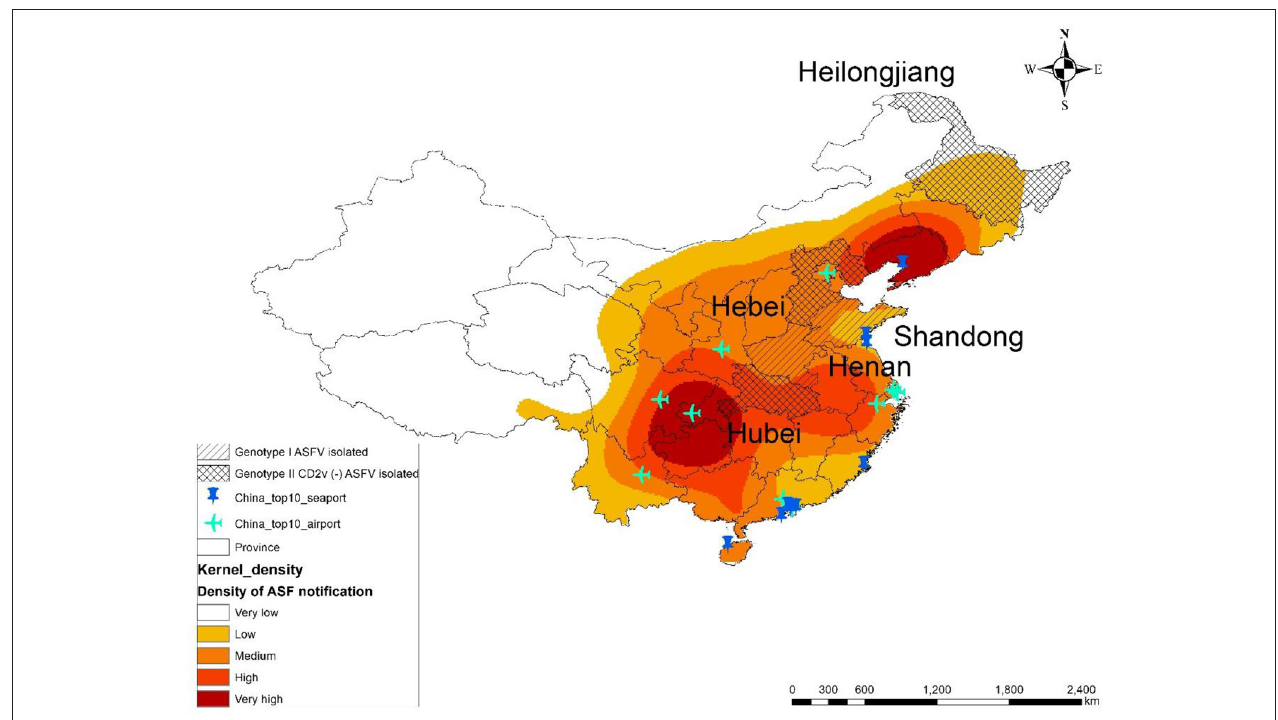
FIGURE 3 | Density of ASF notifications in China overlapped with the lower virulent ASFV reported area and China’s 10 largest airports and seaports. The graduated color shades illustrate the estimated kernel density of ASF notifications (notifications/km 2 ). Each colored area indicates frequency of ASF notification number per > 4.61 × 10 − 5 (very high), 3.11 × 10 − 5 to 4.6 × 10 − 5 (high), 1.81 × 10 − 5 to 3.1 × 10 − 5 (medium), 6.9 × 10 − 6 to 1.8 × 10 − 5 (low), and < 6.9 × 10 − 6 (very low). Provinces where ASFV genotype I and CD2v (–) ASFV genotype II were isolated are represented by a diagonal line and a grid line, respectively. The locations of China’s 10 largest airports and seaports are represented by airplane and pin symbols,